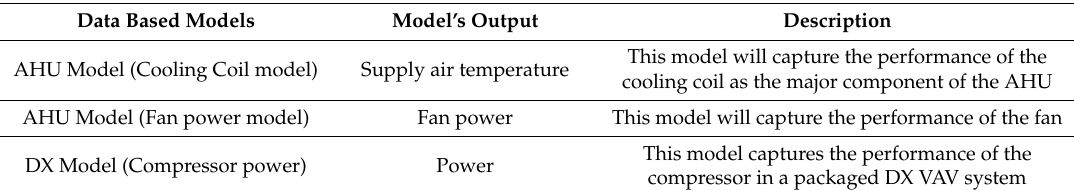
Table 1. List of the major component models.